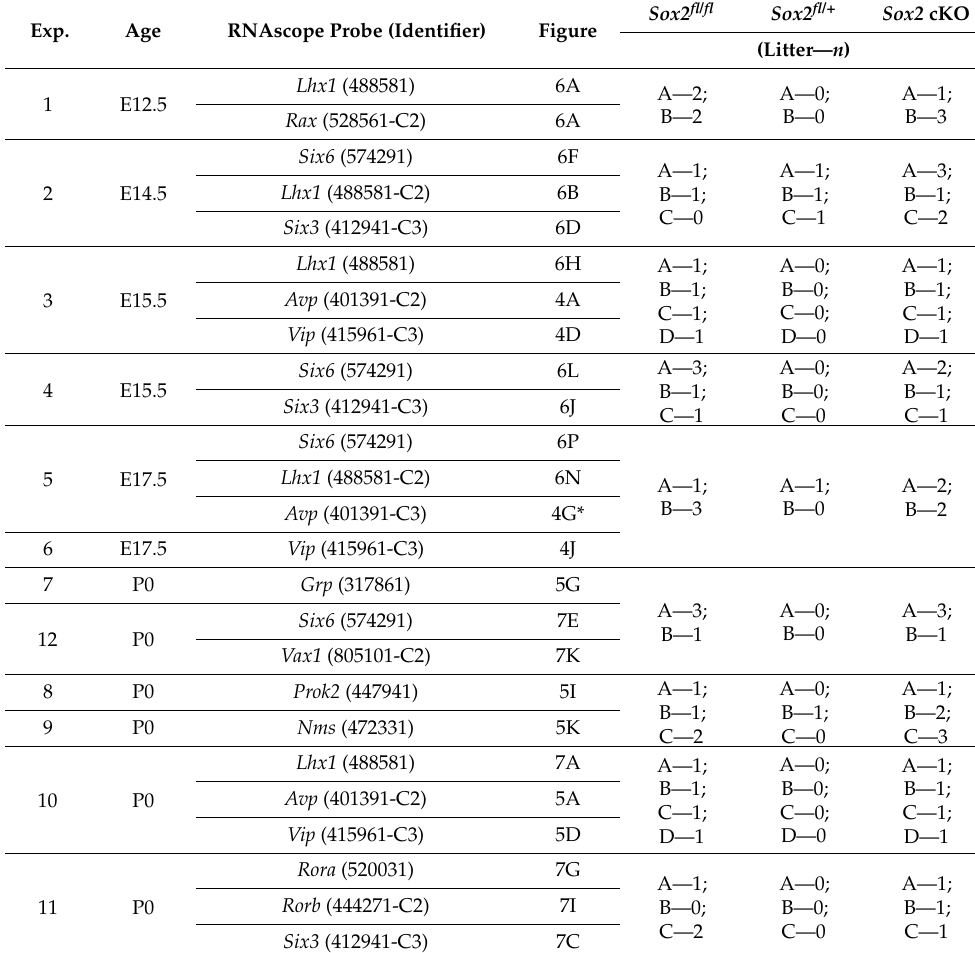
Table 2. Animals, litters, RNAscope probes used and the corresponding representative figures. Exp. Age RNAscope Probe (Identifier)